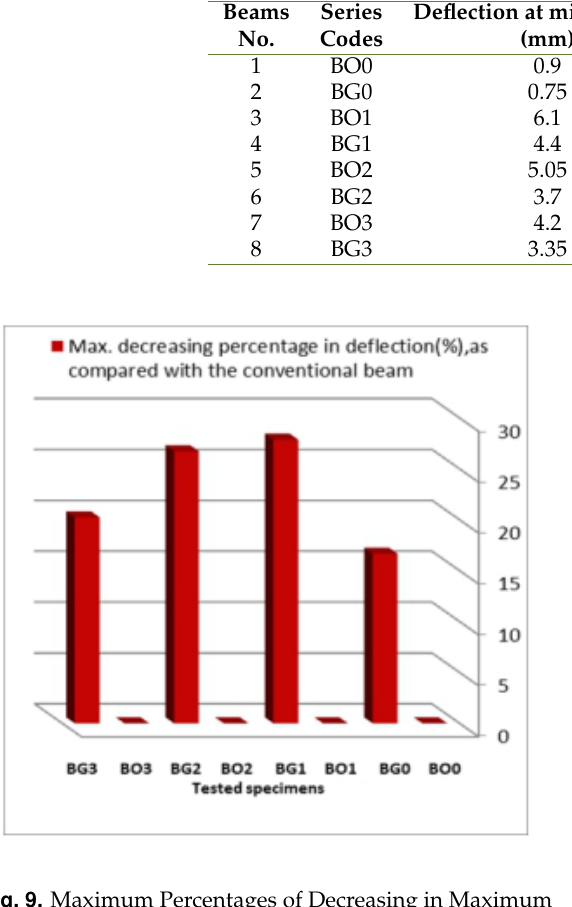
Fig. 9. Maximum Percentages of Decreasing in Maximum Deflection